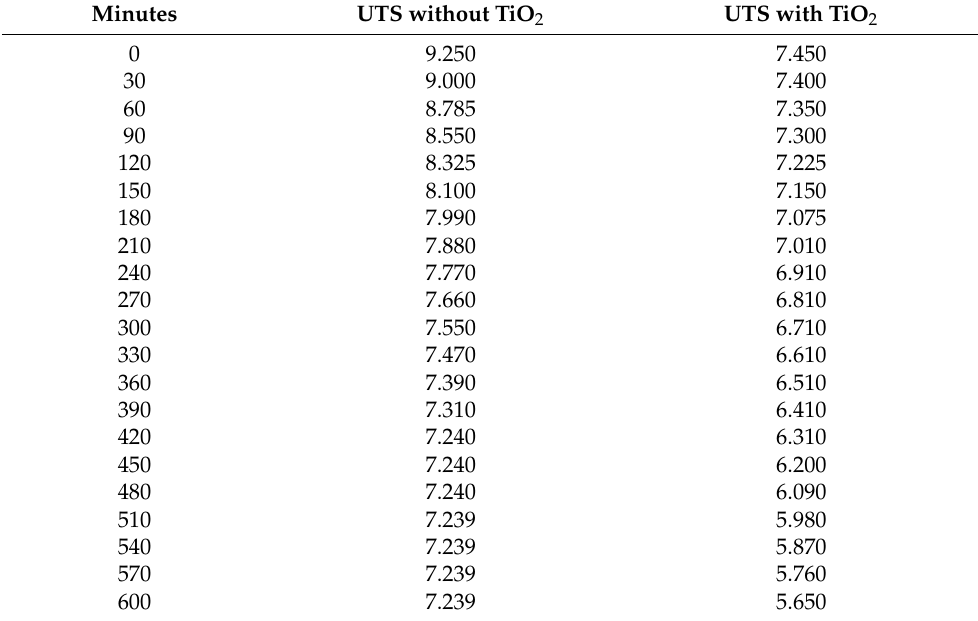
Table 2. Ultimate tensile strength (UTS) value (in Newtons) of polyester fibers as a function of irradiation time (in minutes). Value of UTS are digitized graphs from the paper by Wiener et al. [22]. Minutes UTS without TiO 2 UTS with TiO 2 0